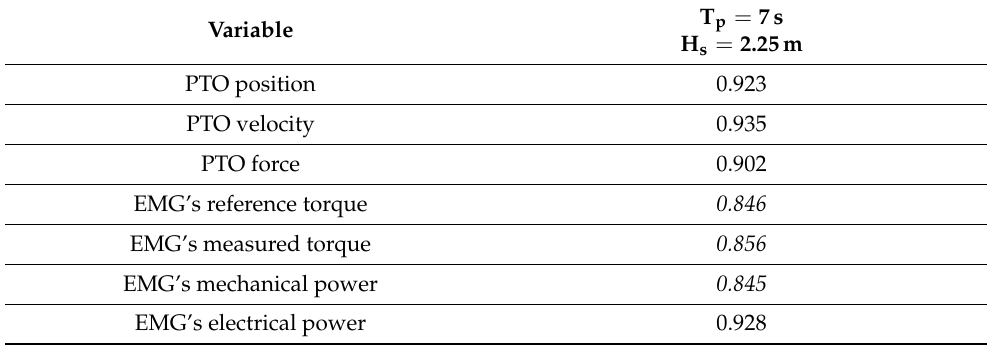
Table 3. NRMSE-based quantitative comparison between offline simulation and HIL real-time